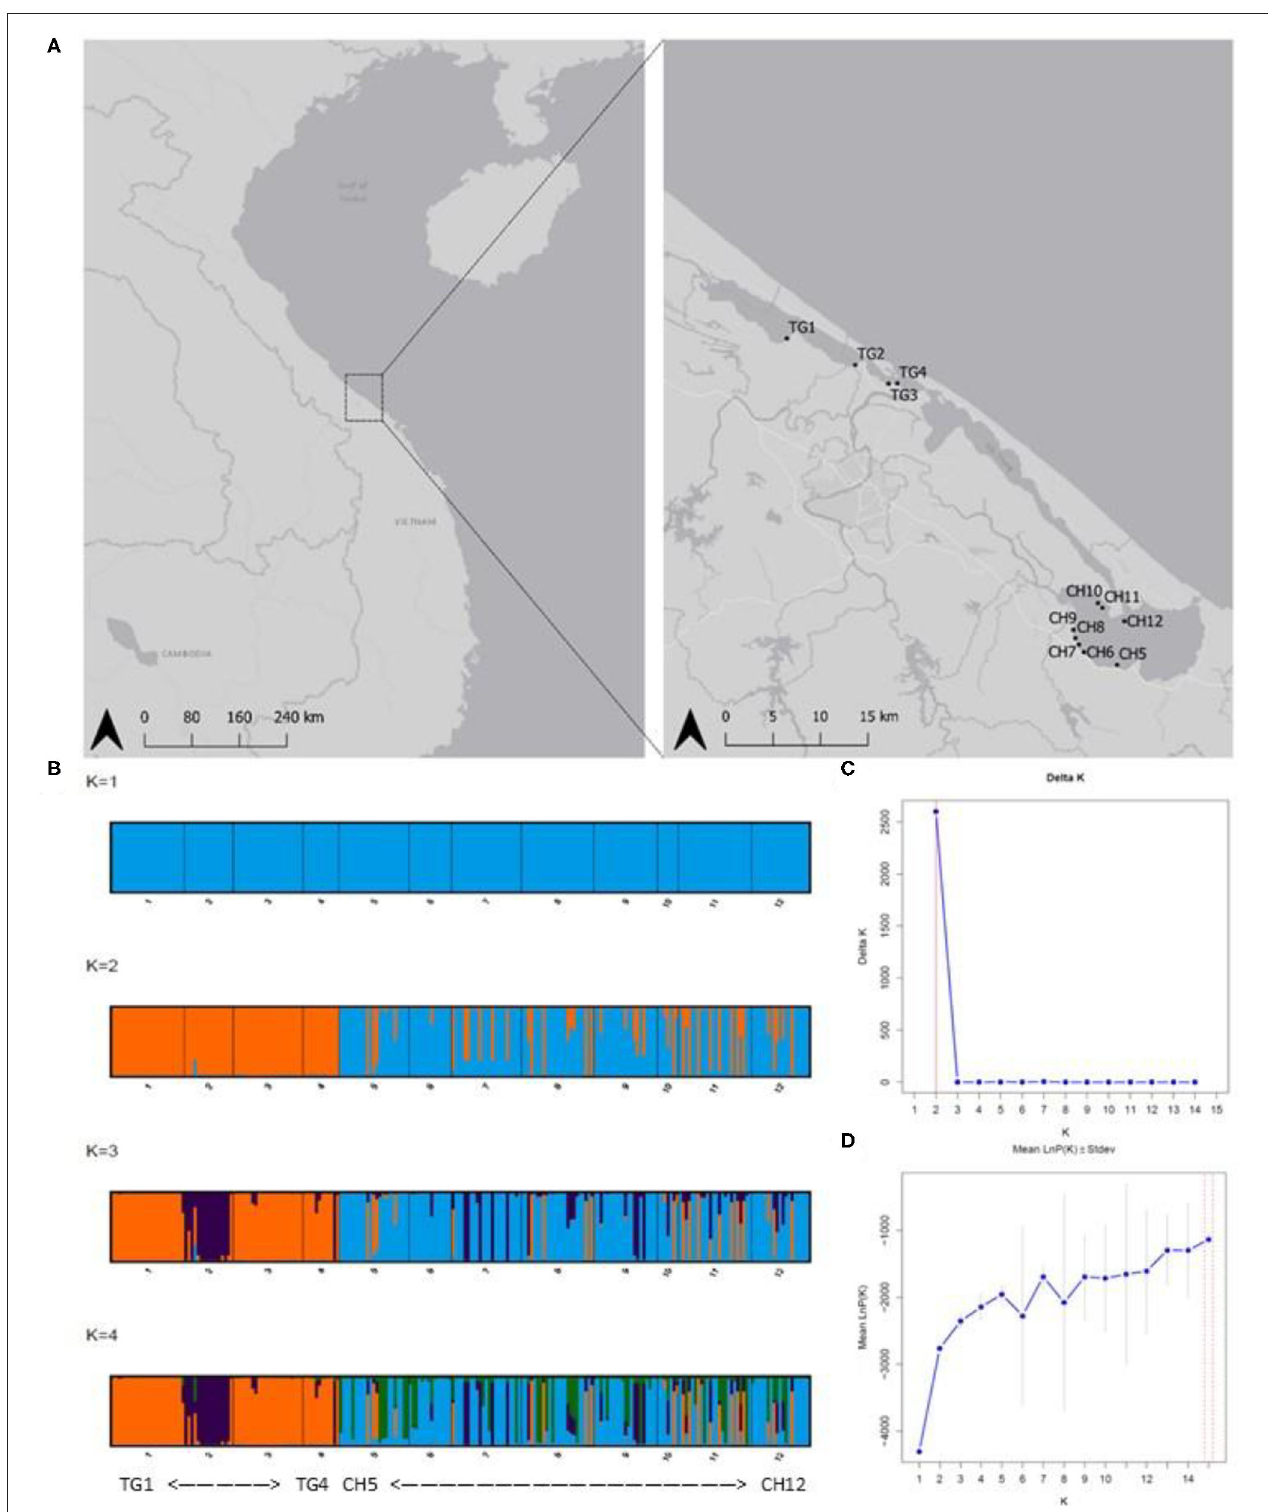
FIGURE 1 | (A) Sampled Ruppia brevipedunculata sites in the Tam Giang (TG)-Cau Hai (CH) lagoon system in Central Viet Nam. Map generated using the Quantum Geographical Information System, version 3.10.3 (QGIS). Basemap source: QGIS. (B) Barplots of Baysian clustering analysis (STRUCTURE from K = 1 to K = 4); (C) Delta K indicating K = 2 clusters; (D) LnP( K ) graphs. Abbreviations of sample locations are denoted in Table 1 .